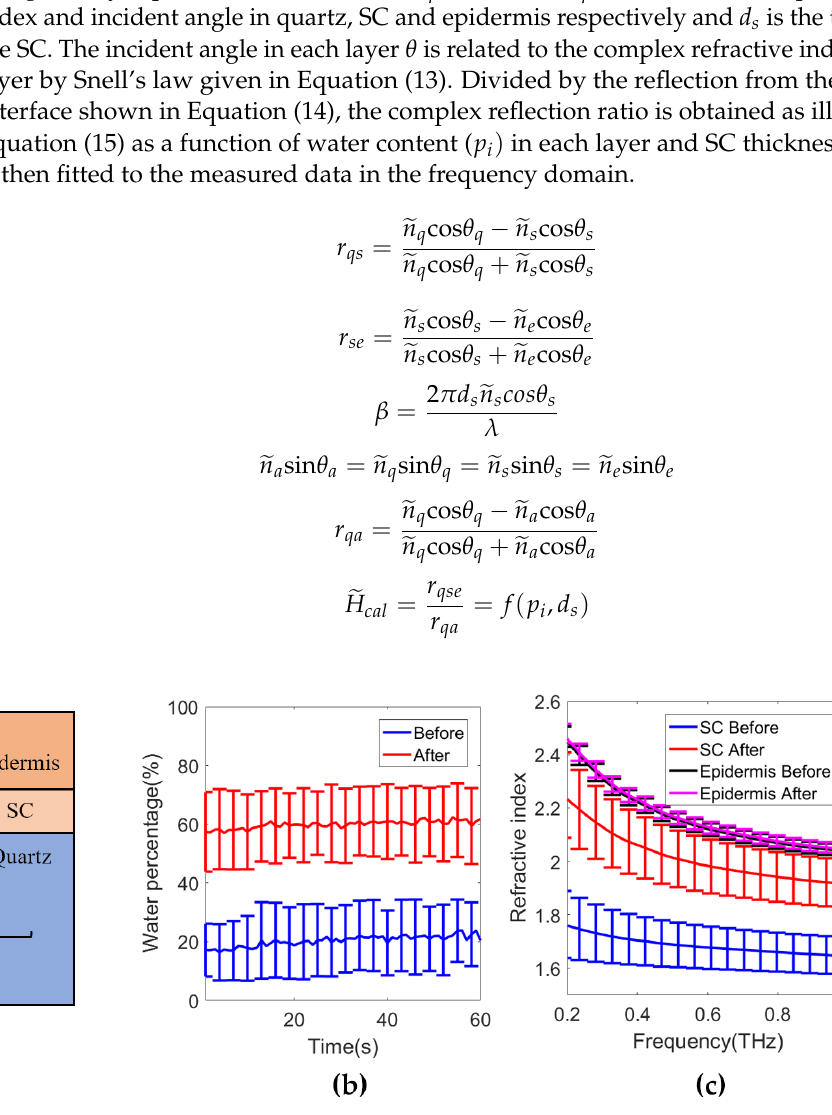
Figure 5. ( a ) Diagram of the THz interaction with a two-layer skin model consisting of SC and epidermis; ( b ) Water content in the SC and ( c ) refractive index in the SC and epidermis, before and after the application of silicone gel sheeting, respectively [35].